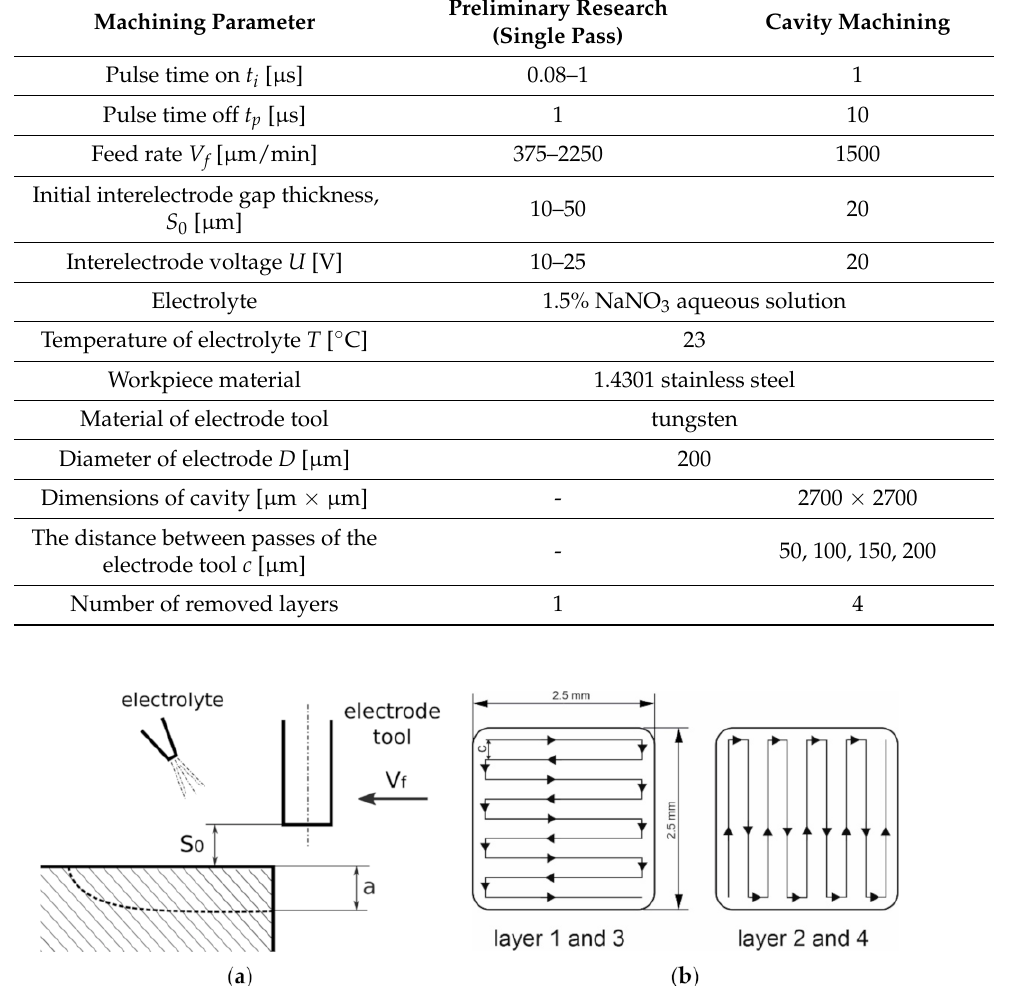
Table 3. Input and constant machining parameters used during test on shaping of cavity with rectangular cross-section.